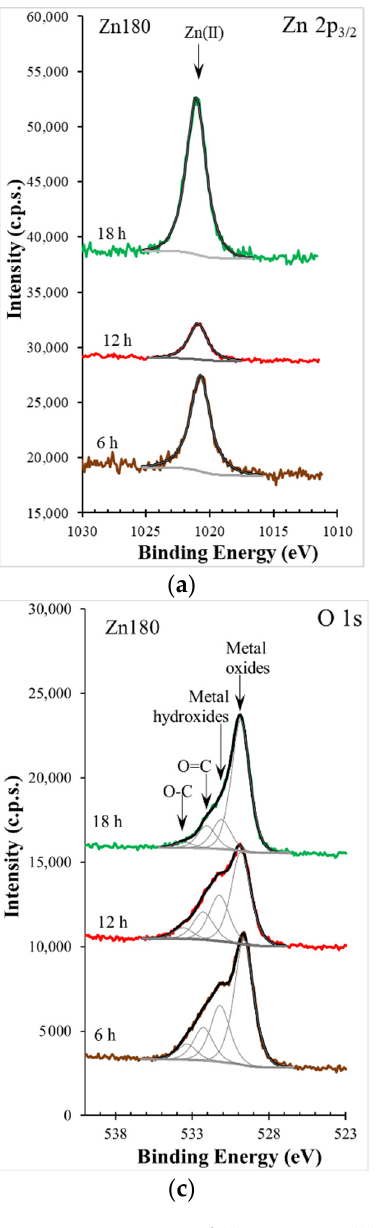
Figure 5. XPS regions of ( a ) Zn 2p 3/2 , ( b ) Mn 2p 3/2 , ( c ) O 1 s, and ( d ) C 1s of ZnMn 2 O 4 obtained at different times, 6 h (brown), 12 h (red), and 18 h (green).